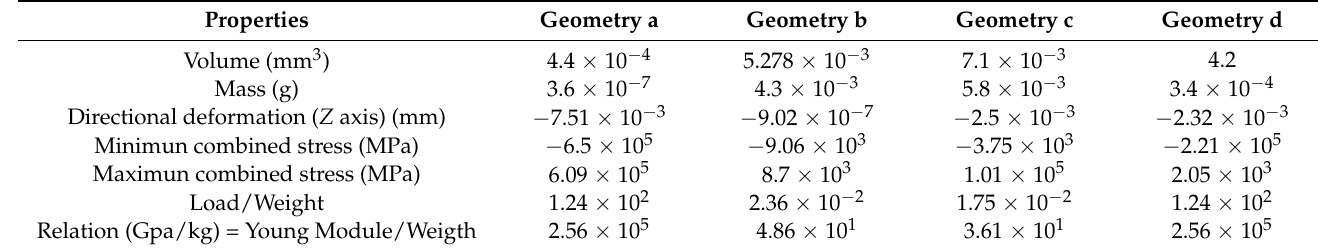
Figure 8. ( a ) Octahedron microstructure latice made of nine octahedrons, ( b ) 6 octahedrons mi- crostructure, ( c ) octahedron microstructure made of octahedron lattice. Table 5. Geometries properties.